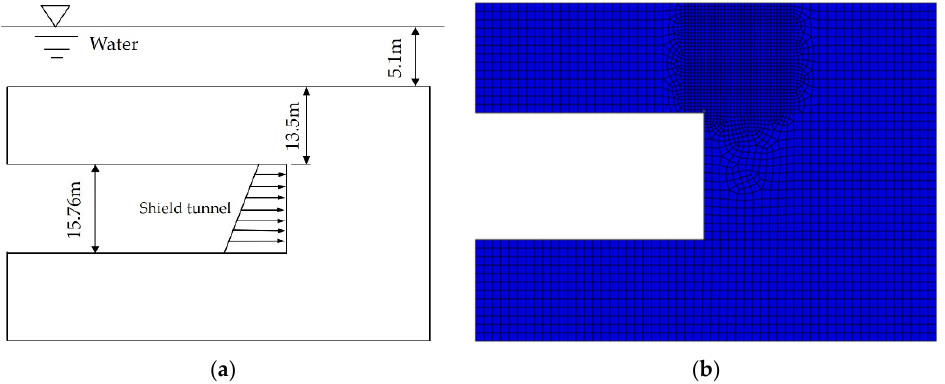
Figure 15. The section overview and model of the position EK4 + 820. ( a ) The section overview; ( b ) The section model.